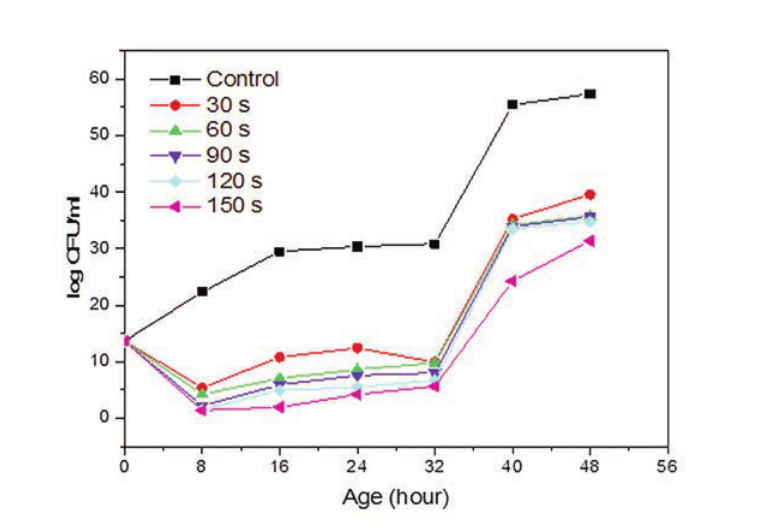
Figure 2. ELISA’s analysis of graphs in the control and treatment groups at each biofim age.